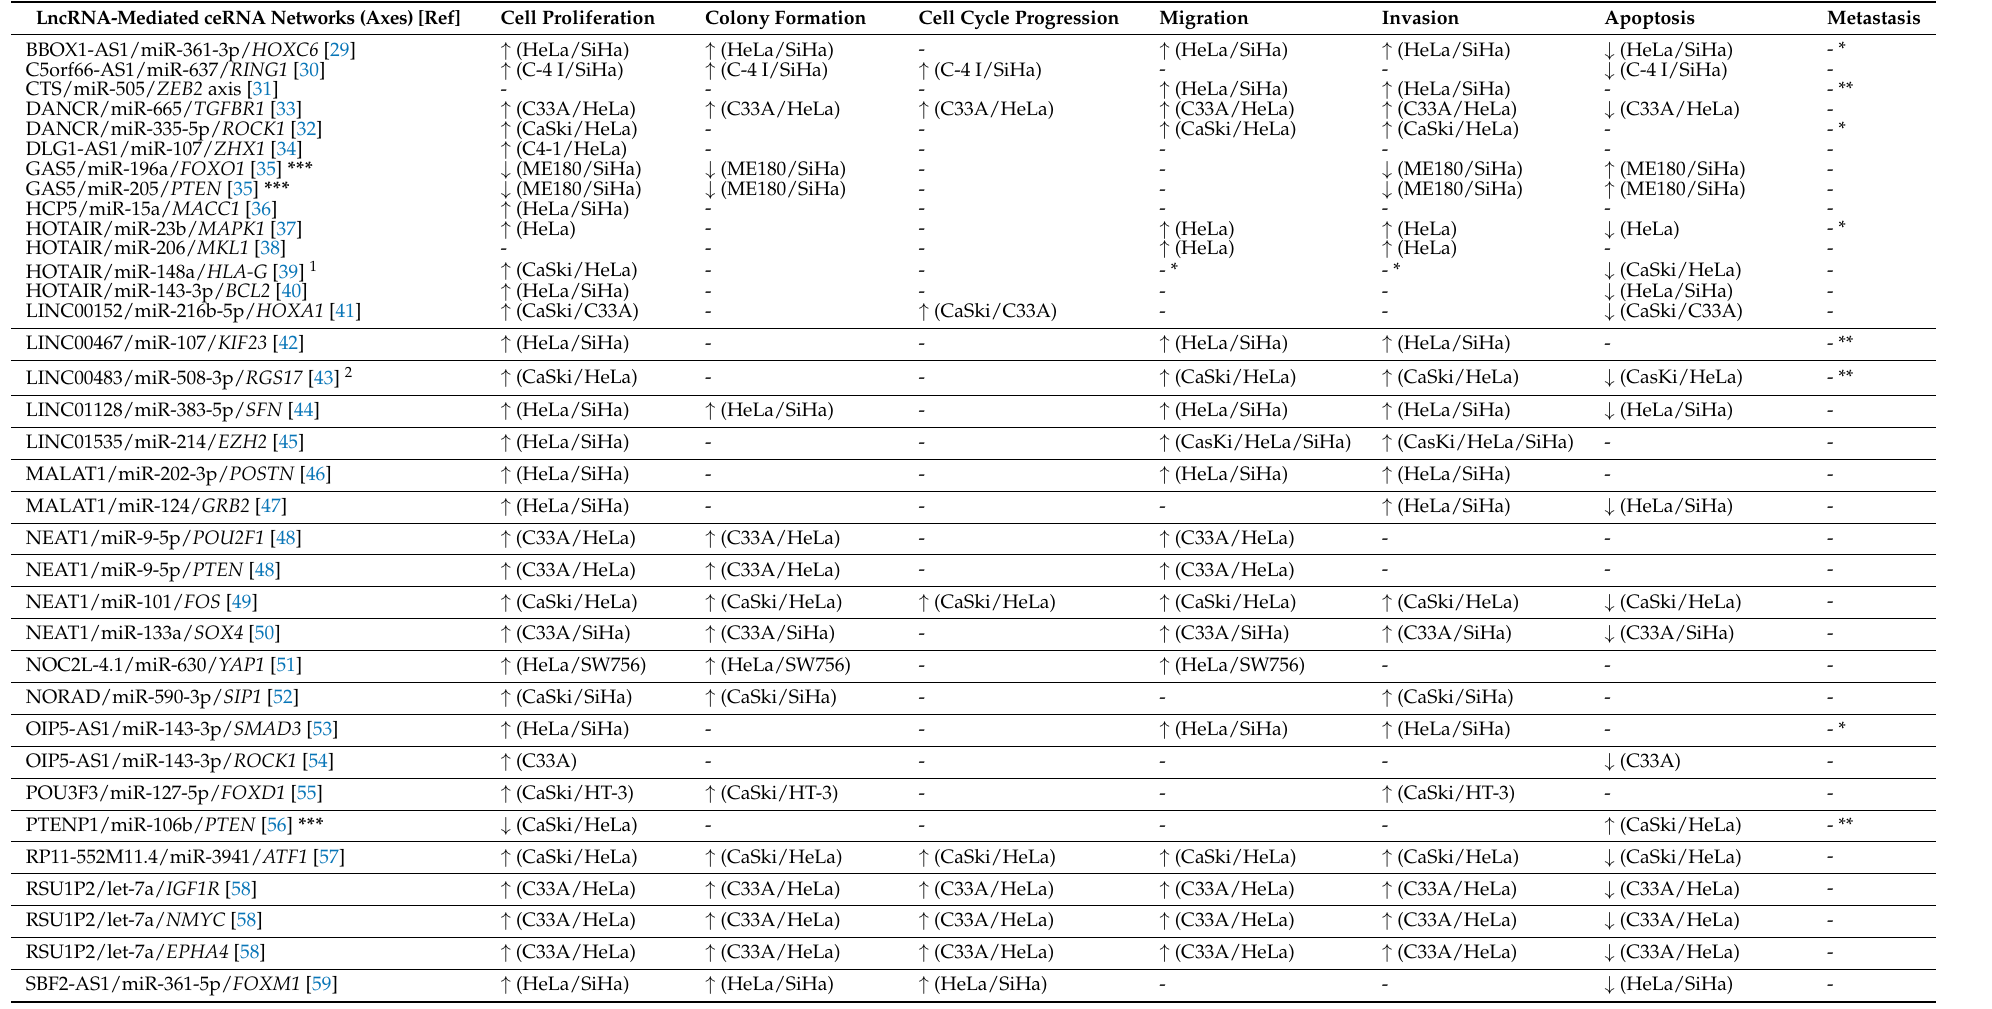
Table 2. Biological effects promoted by different lncRNA-mediated ceRNA networks (in vitro